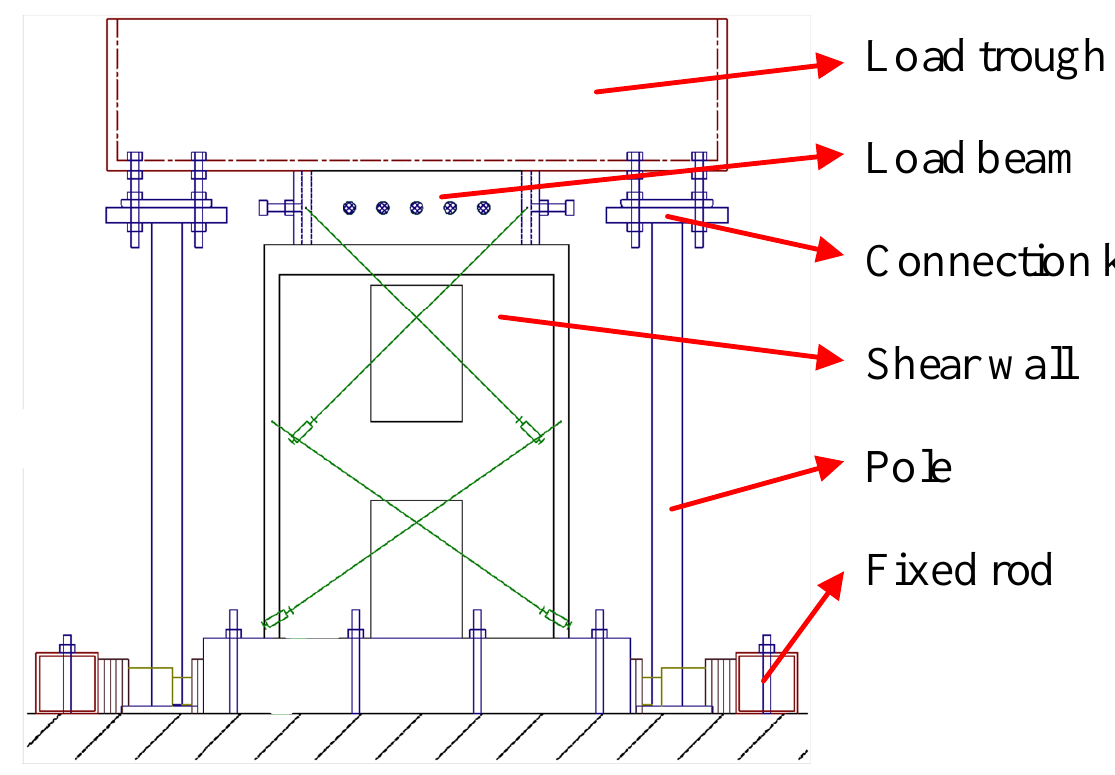
Figure 2. Schematic diagram of test setup [19].